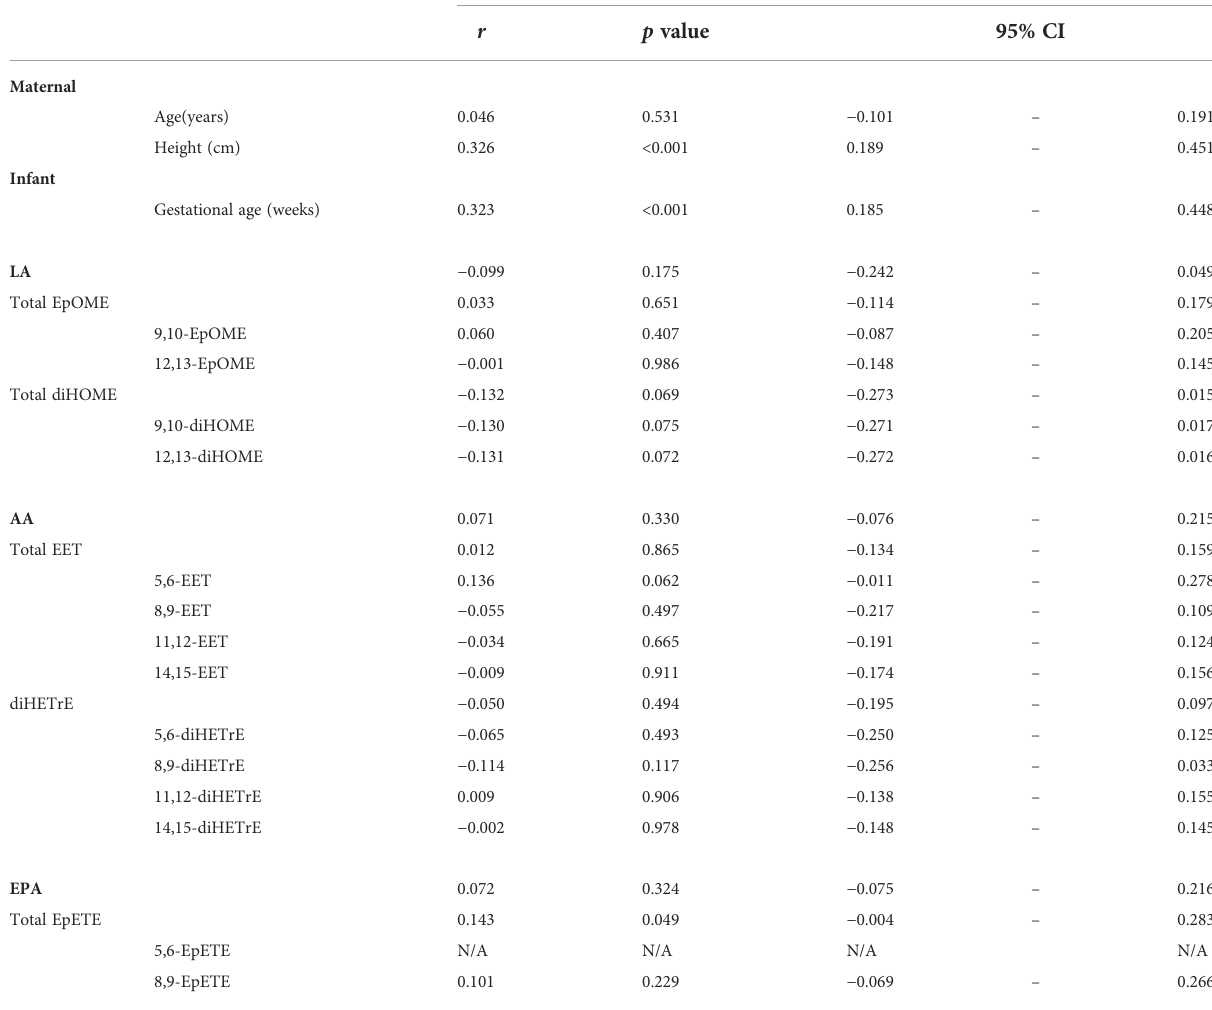
TABLE 3 Correlation between birth weight and PUFA metabolite in cord